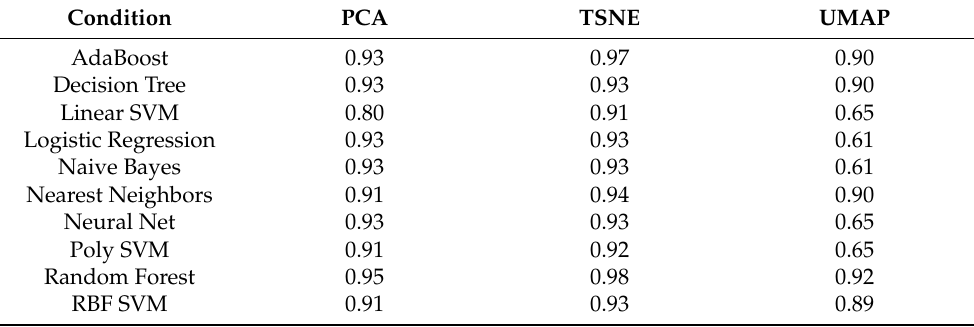
Table 4. Accuracy for all tested combinations of shallow learning methods and data reduction.